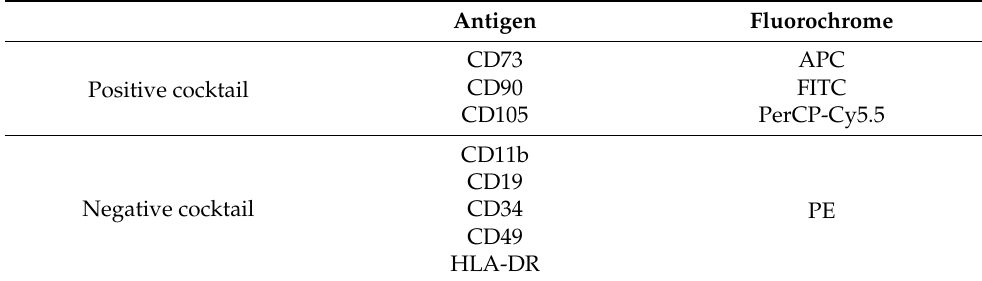
Table 1. List of antibodies used for flow cytometry—Human mesenchymal stem/stromal cell (MSC) Analysis Kit (Beckton Dickinson) (cat. nr